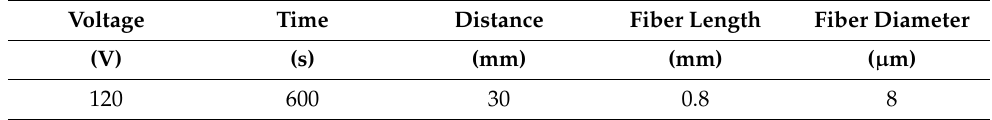
Table 4. The parameters of electrostatic flocking.